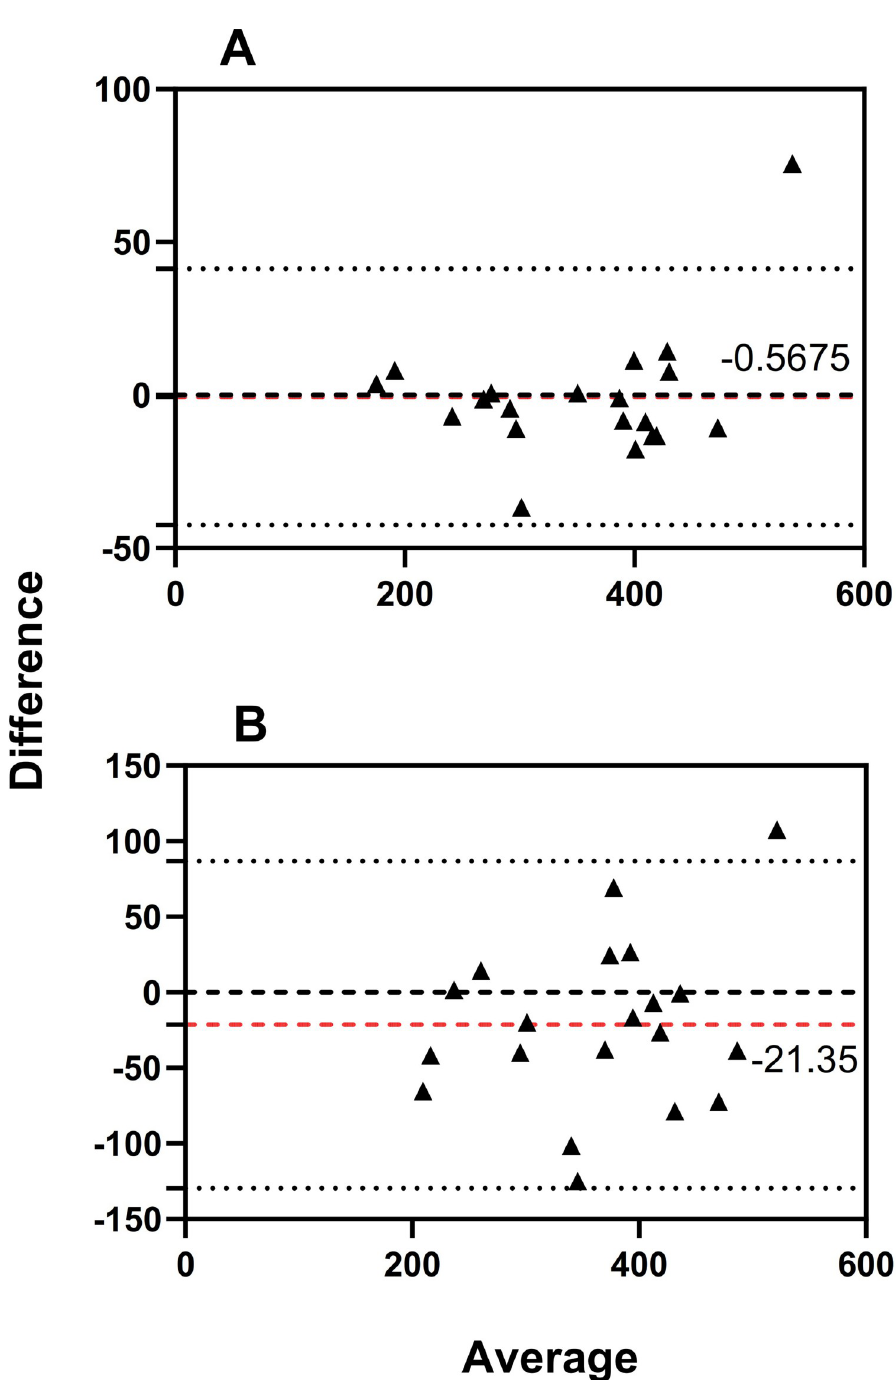
Fig 2. Bias of measurement between different operators ( Ⅰ and Ⅱ ) and limits of agreement are represented by a red dotted and two black solid lines respectively. A: Bland-Altman plot of the inter-rater reliability for the erector spinae stiffness. B: Bland-Altman plot of the intra-rater reliability for the erector spinae stiffness. non-painful sides, muscle stiffness increased slowly (from 257.20 to 357.13 N/m, P < .01, an increase of 38.85%) (Fig 3).